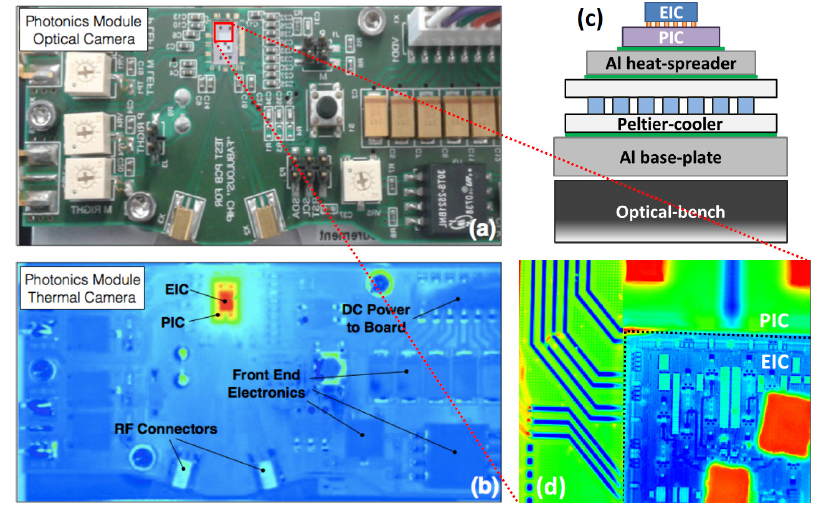
Figure 14. Thermal imaging of a photonic module and PIC; ( a , b ) A comparison of optical and thermal imaging of the optical network unit (ONU) packaged for the FP7 ‐ FABULOU project. Once powered ‐ up, both the EIC and PIC experience a significant increase in temperature (34 °C and 20 °C, respectively); ( c ) Schematic of the ‘thermal stack’ in the ONU, showing the conduction path from the EIC to to the baseplate; ( d ) Thermal microscopy of the EIC and PIC on the ONU. Silicon is transparent in the 3–5 μ m wavelength range at which the sensor operates, allowing the user to ‘see through’ the EIC substrates and image the metallic structures on the surface of the EIC and PIC. The effect of unchecked Joule ‐ heating can be illustrated by powering ‐ up the EIC while the TEC is powered ‐ down, as shown in Figure 15. Here, 1.1 W of power is applied to the EIC in a Si photonic optical network unit (ONU), developed for the the EU ‐ FP7 ‘FABULOUS’ project [57], which results in a temperature increase of 34 °C and 20 °C for EIC and PIC, respectively. These measurements were made using a thermal microscope, which allows for accurate, non ‐ contact temperature measurements,